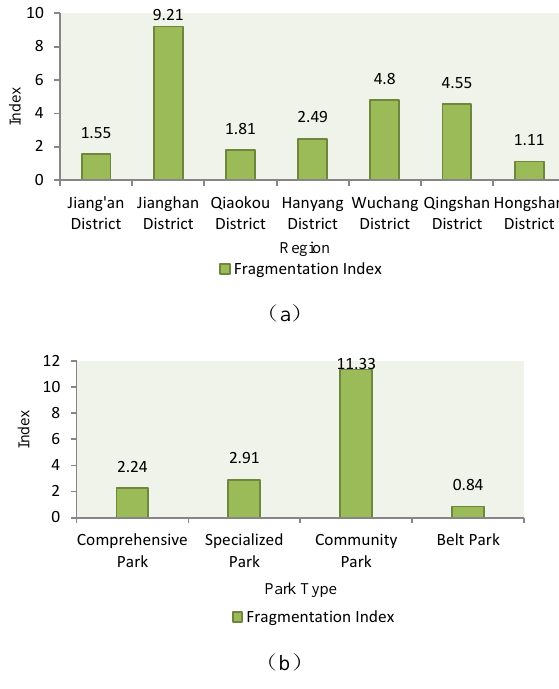
Figure 5. Landscape fragmentation degree of park green space in Wuhan main urban